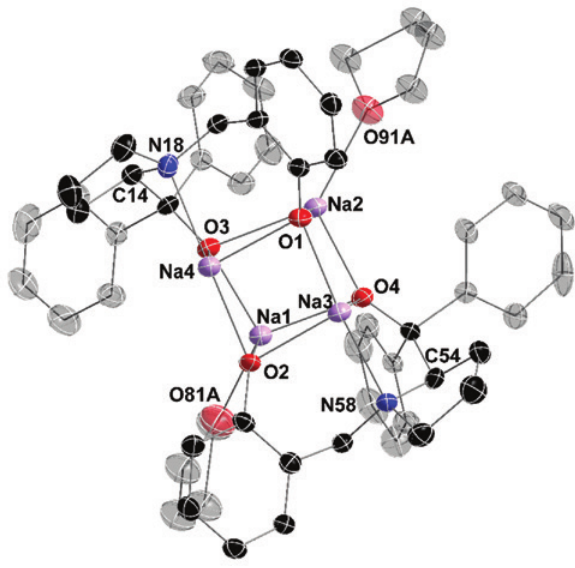
Figure 4: ORTEP representation of the molecular solid-state struc- ture of [( S )-{OˆO}Na ·THF] . 2 2 Ellipsoids drawn at the 30% probability level. H atoms and t Bu groups omitted and THF molecules and C H substituents in shaded tone for 6 5 clarity. Selected bond lengths (Å): Na1-O2 = 2.376(6), Na1-O3 = 2.252(5), Na1-O4 = 2.421(6), Na1-O81A = 2.347(8), Na2-O1 = 2.380(6), Na2-O3 = 2.522(6), Na2-O4 = 2.246(5), Na2-O91A = 2.437(7), Na3-O1 = 2.280(5), Na3-O2 = 2.296(6), Na3-O4 = 2.297(6), Na4-O2 = 2.307(5), Na4-O1 = 2.324(6), Na4-O3 = 2.256(6).